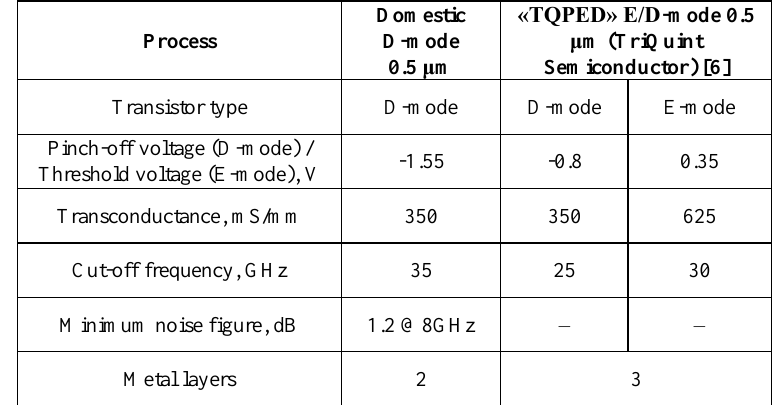
Table 1. GaAs pHEMT 0.5 μm process